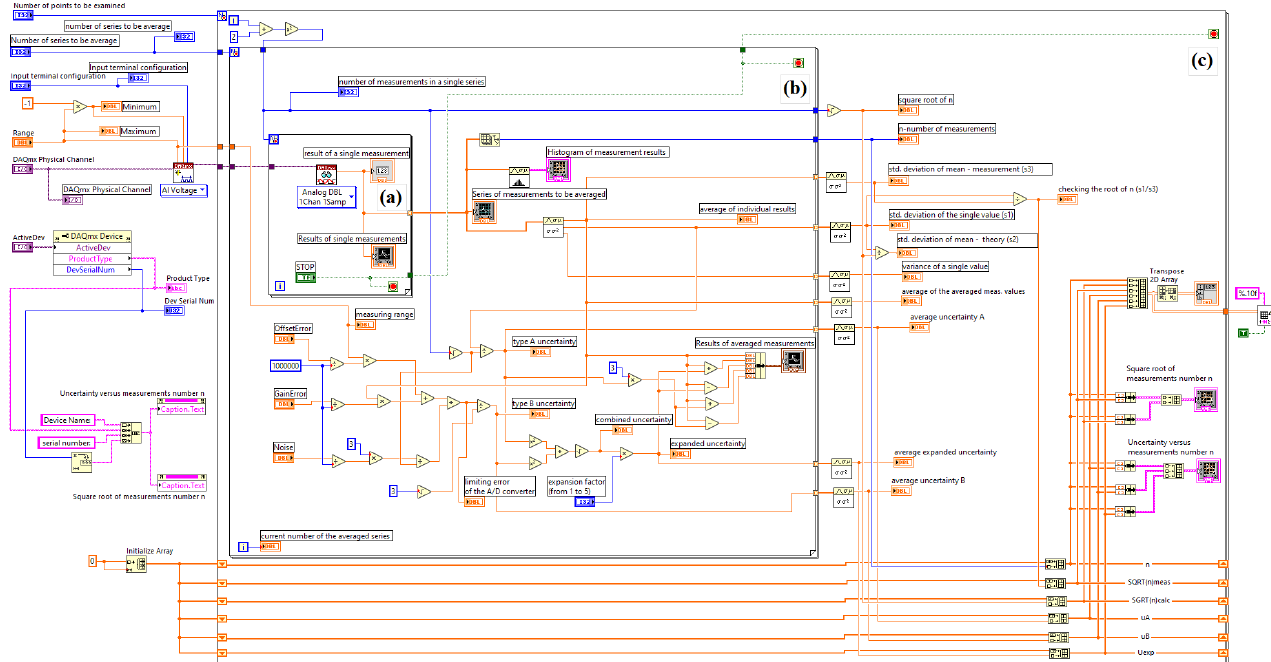
Figure 6. Diagram of the program performing the measurements: ( a ) internal loop performing a series of single measurements; ( b ) loop repeating successive series of measurements; ( c ) main loop modifying the number of measurements in the series.